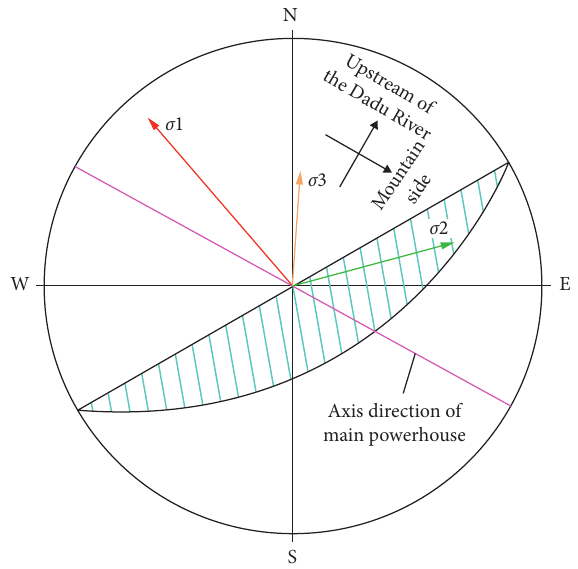
Figure 6: Spatial relationship between the axis principle